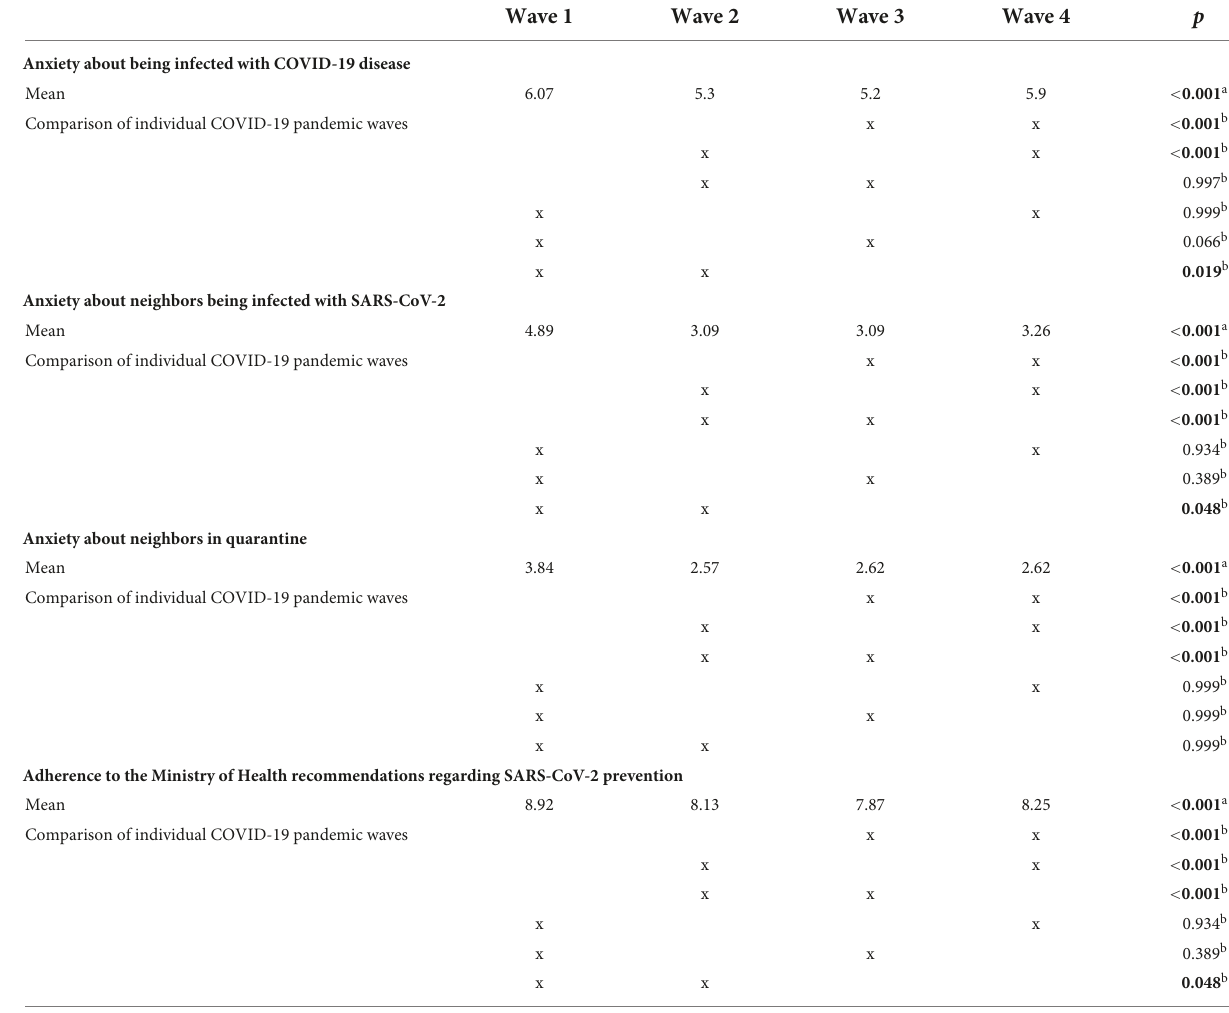
TABLE 4 Comparison of the mean values of the assessment of fear of disease, fear due to neighbor’s disease and neighbor’s quarantine, and adherence to government recommendations for each wave of the pandemic. Wave